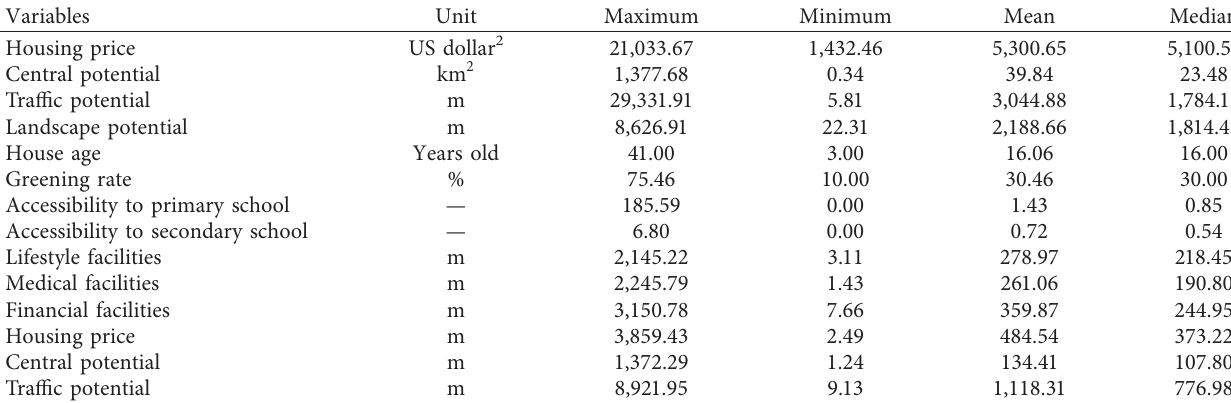
Table 2: Descriptive statistics of